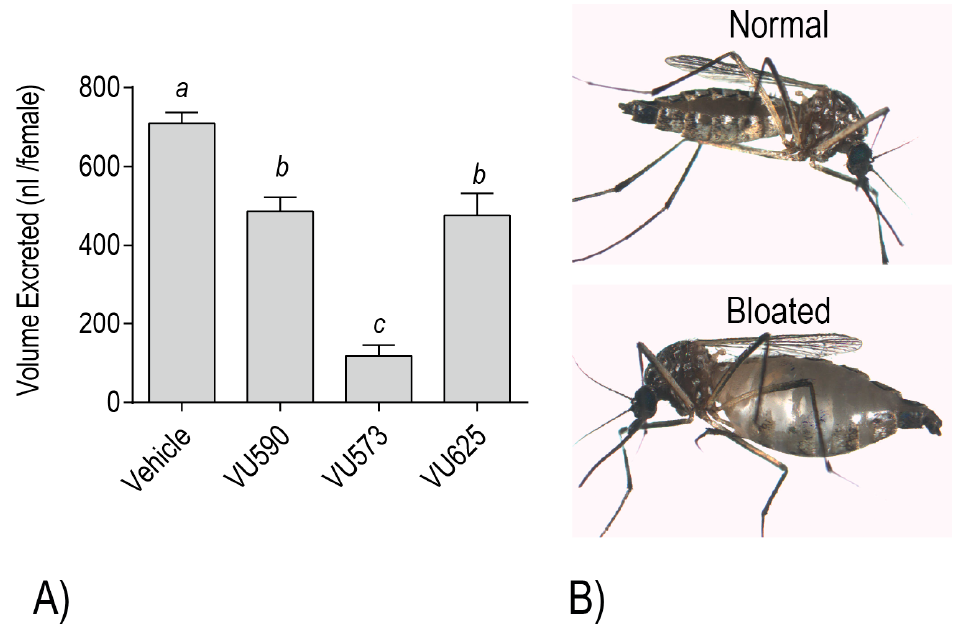
Figure 6. ( A ) Effects of small molecule inhibitors of Ae Kir1 on the diuretic capacity of adult female mosquitoes ( Ae. aegypti ). Small molecules (690 pmol per mosquito) were delivered to the hemolymph along with 900 nL of phosphate-buffered saline (PBS) via microinjection to stimulate diuresis. The amount of urine excreted was measured 60 min after injection. The vehicle consisted of PBS containing 1.15% DMSO, 0.077% β -cyclodextran, and 0.008% Solutol. Values are means ± SEM. Lowercase letters indicate statistical categorization of the means as determined by a one-way ANOVA with a Newman-Keuls posttest ( p < 0.05). Data are from [19–21]. ( B ) Adult females with normal and bloated abdomens 24 h after hemolymph injection of the vehicle or VU573, respectively. Similar results were observed after injection with VU590 [20]. Images are from [18].